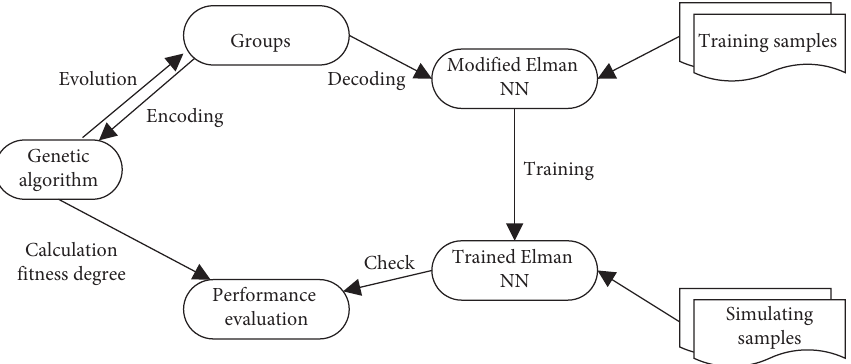
Figure 3: Flow chart of GA-Elman